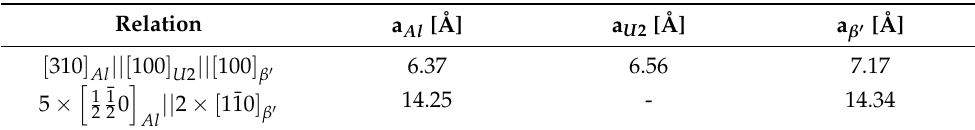
Table 2. Coherency relations for β (cid:48) , U2 and the aluminium matrix in the directions of the interfaces investigated.